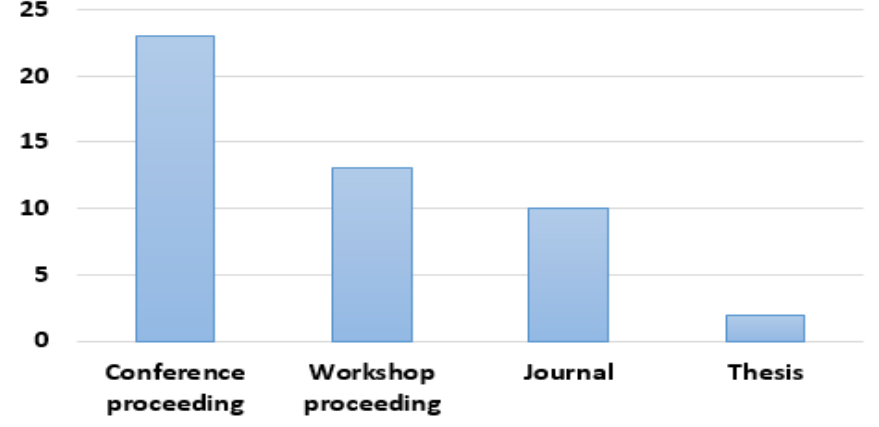
Figure 3. Articles by publication type.